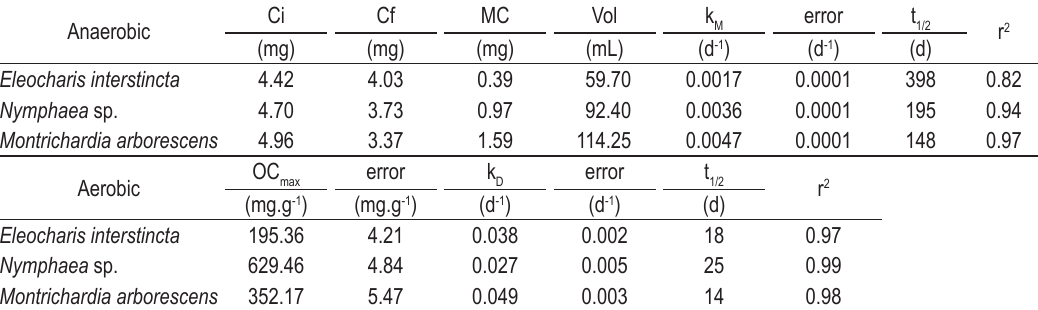
Table 1. Carbon budget and kinetics parameters related with anaerobic and aerobic mineralization of aquatic plants. Ci Cf Anaerobic